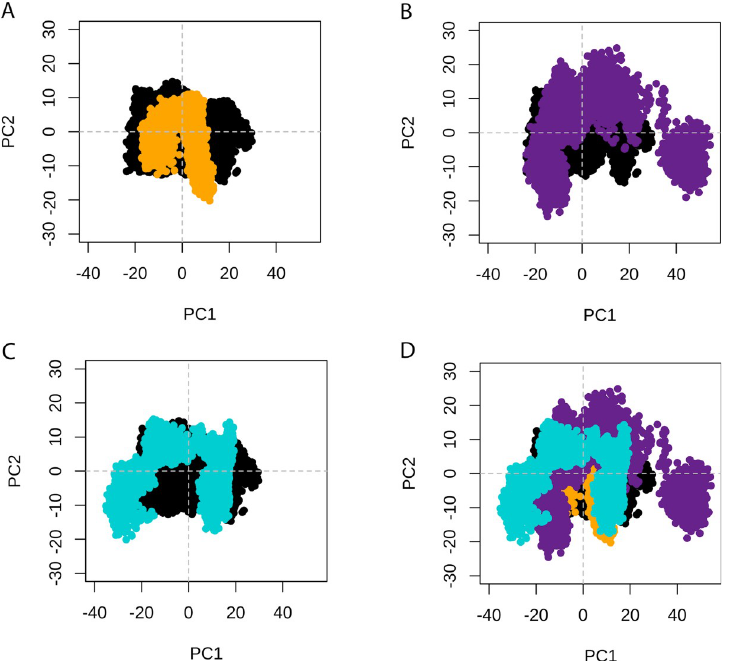
Fig 7. PCA of WT TPH2 and its variants. Projection of the first two principal components (PC1 and PC2) extracted from the essential dynamics. (A) PCA comparison between WT TPH2 (black) and its variant P206S (dark yellow). (B) PCA comparison between WT TPH2 (black) and its variant R303W (purple). (C) PCA comparison between WT TPH2 (black) and its variant R441H (turquoise). (D) Superimposed PCA comparison between WT TPH (black) and its variants P206S (dark yellow), R303W (purple), and R441H